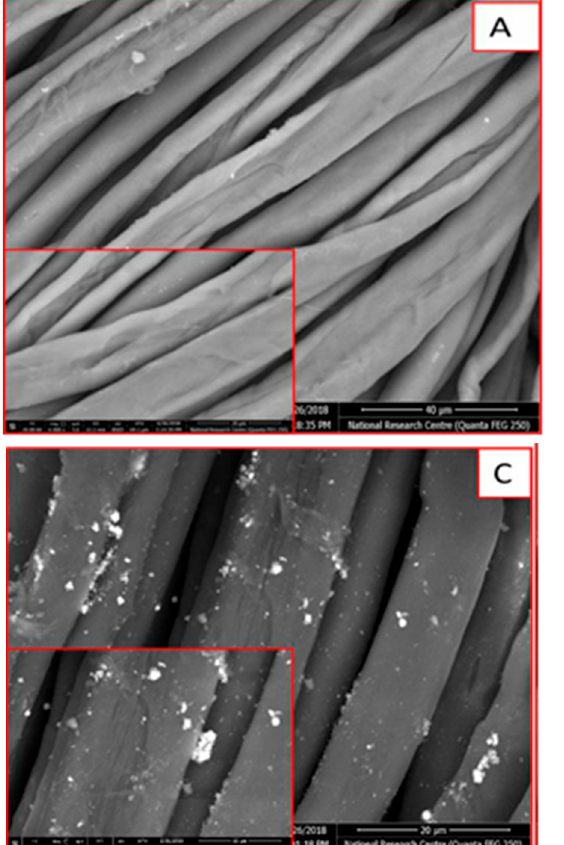
Figure 6. SEM images of ( A ) untreated fabric, ( B ) ZnONPs-1@CF, ( C ) ZnONPs-2@CF, and ( D ) ZnONPs-3@CF.